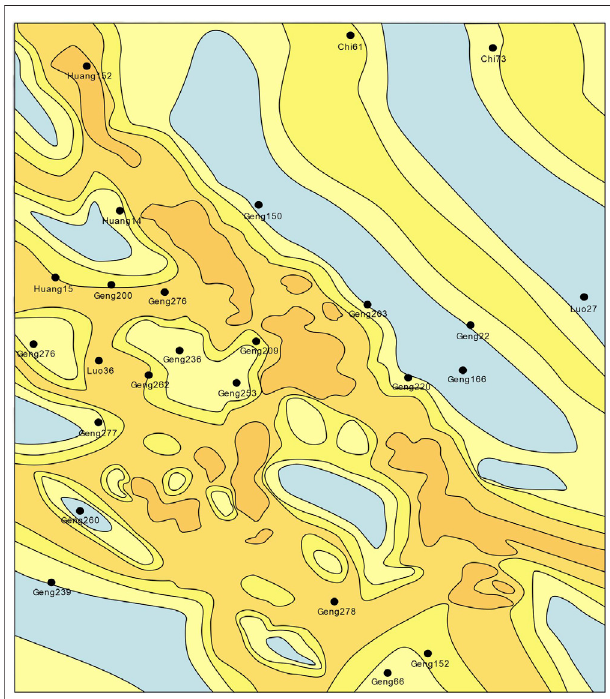
FIGURE 1 | Sand body distribution in the study